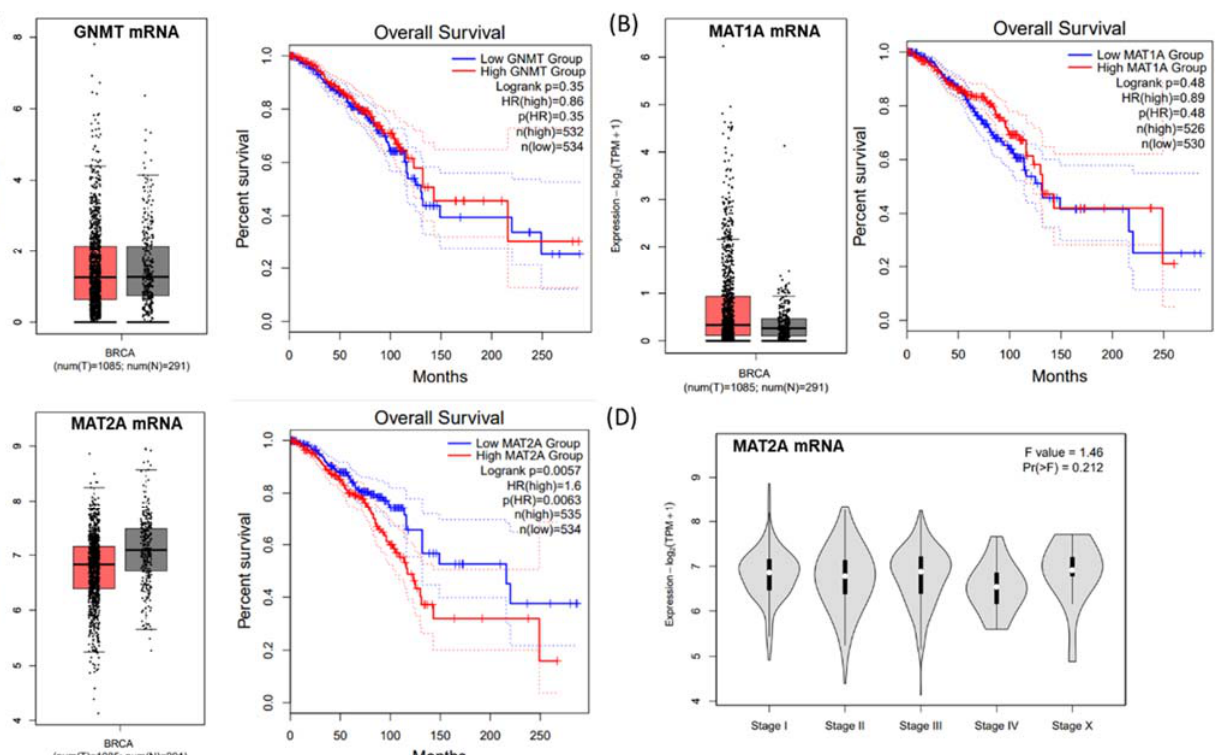
Figure 1. GNMT , MAT1A and MAT2A mRNA expression from a published RNA-seq data set. ( A ) No difference was observed in GNMT ( A ) or MAT1A ( B ) mRNA expressions between breast cancer tissues and normal tissues, and no association was found in these genes with overall survival rate. ( C ) The median of MAT2A mRNA expression level in breast tumorous tissues tended to be lower in breast cancer compared to that of the normal tissues; however, a longer survival rate was found in patients with lower MAT2A mRNA levels of the tumor tissue, ( D ) No association was found between MAT2A mRNA expression and tumor